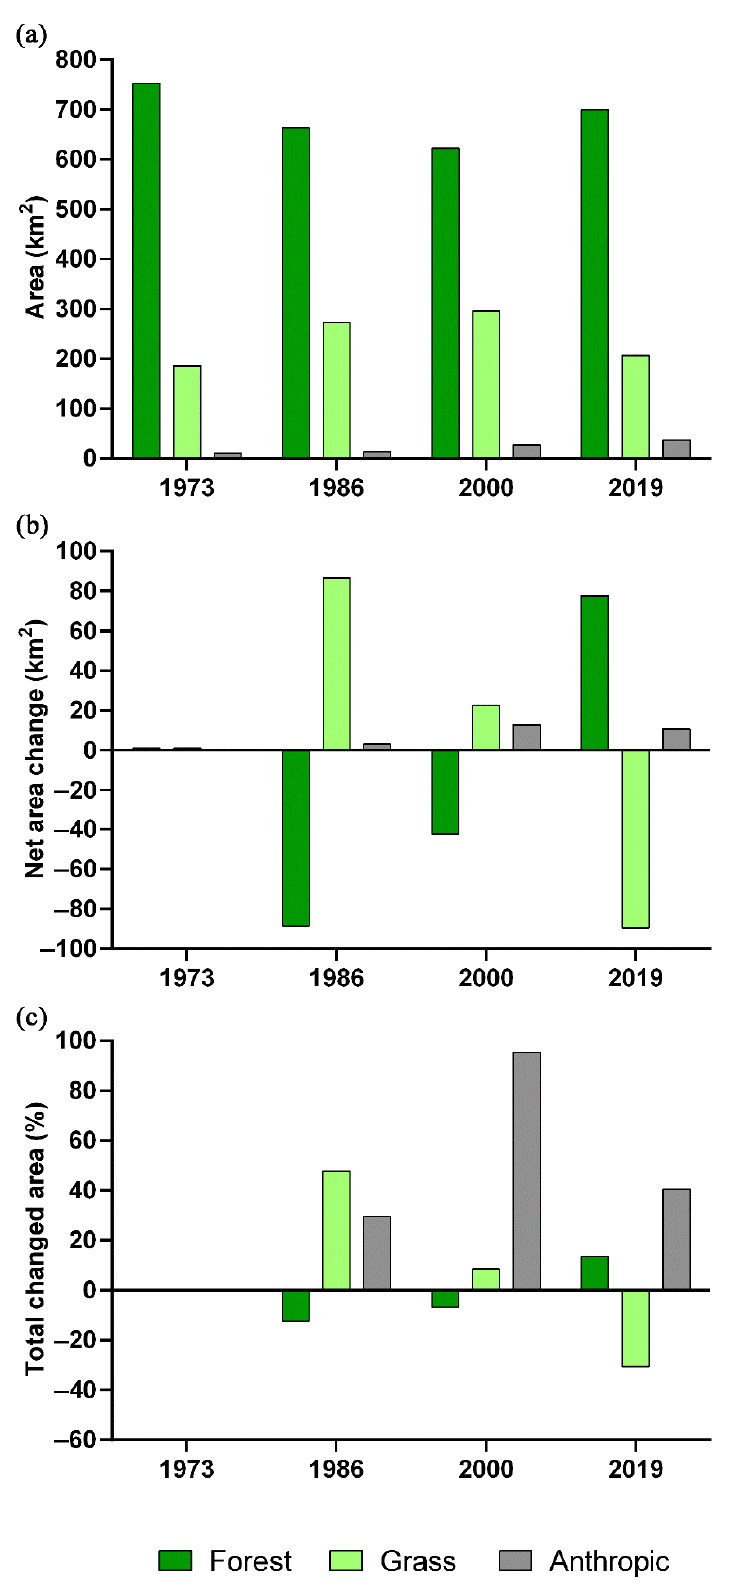
Figure 3. ( a ) The overall area (km 2 ) of classes forest, grass, and anthropic in the Hola Basin, Northeast China, in 1973, 1986, 2000, and 2019; ( b ) the net change of classes area in km 2 , and ( c ) the net change of classes area in %.